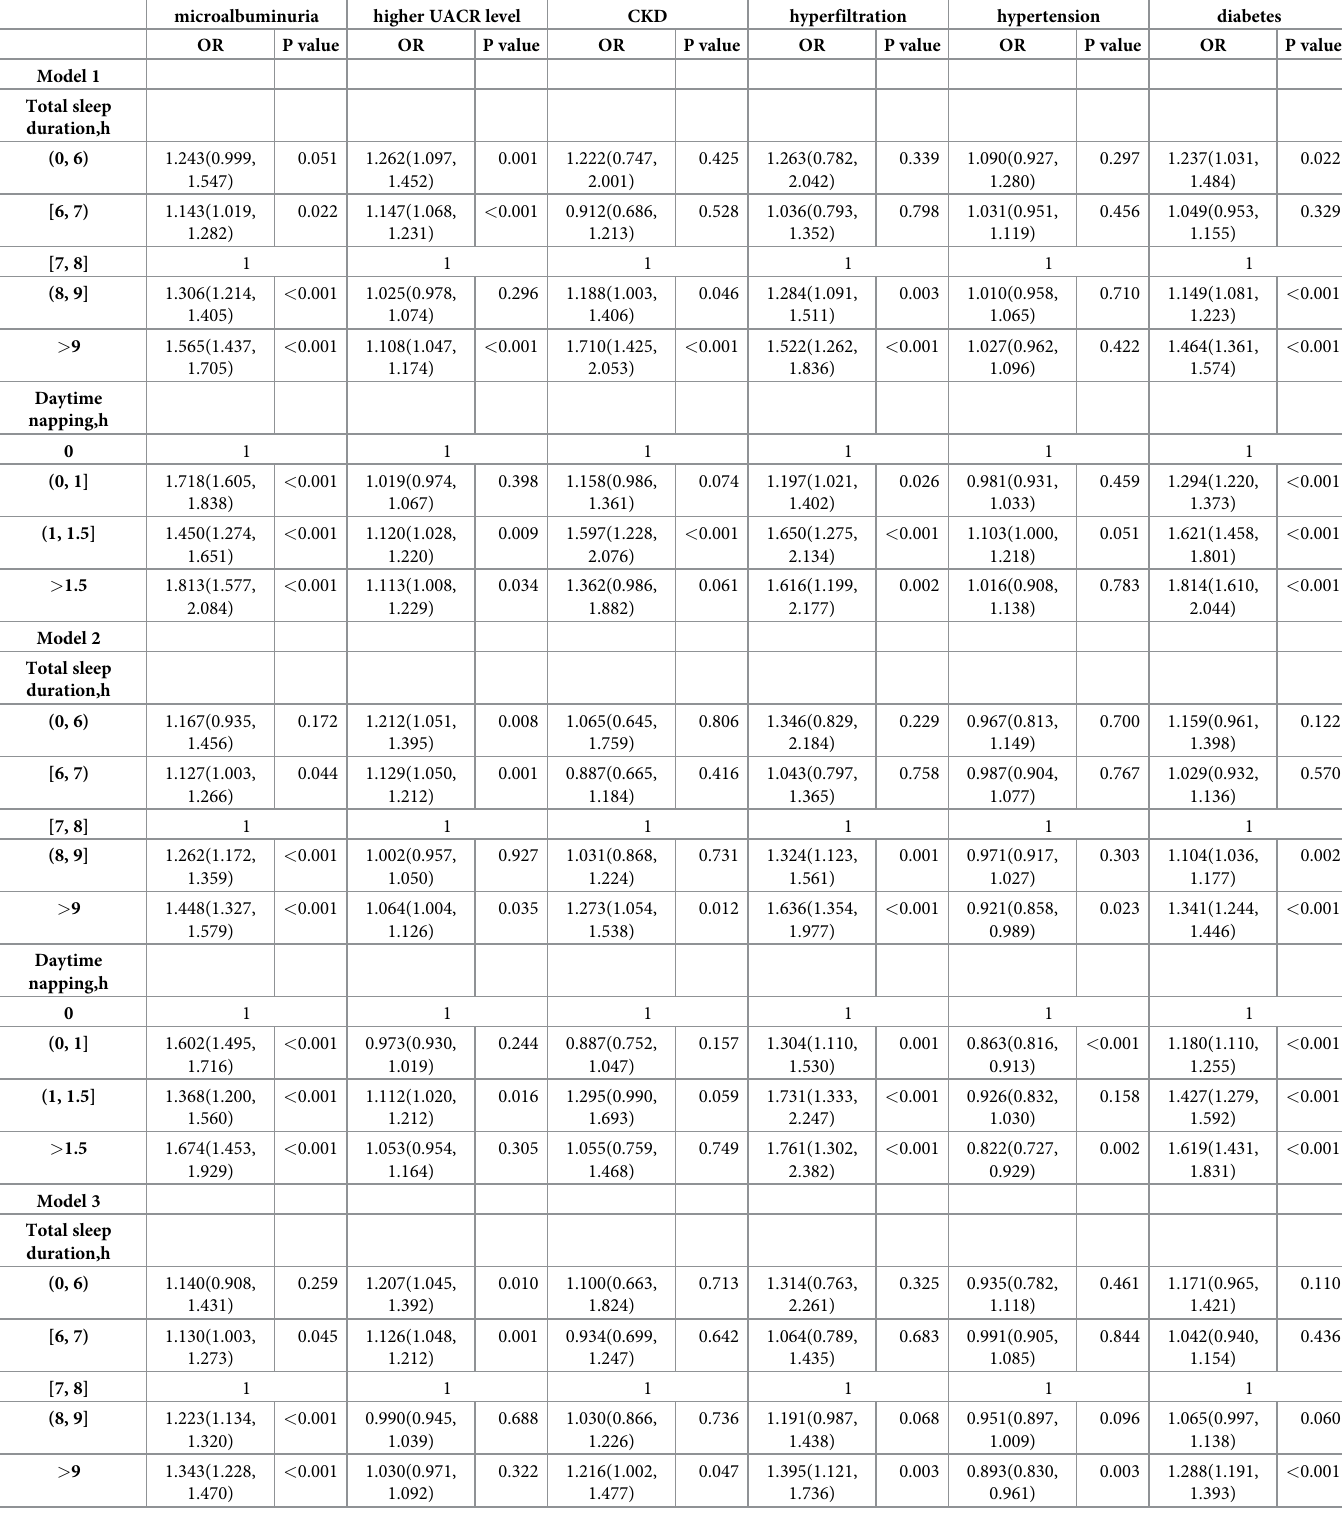
Table 3. Risk for health outcomes according to total sleep duration and daytime